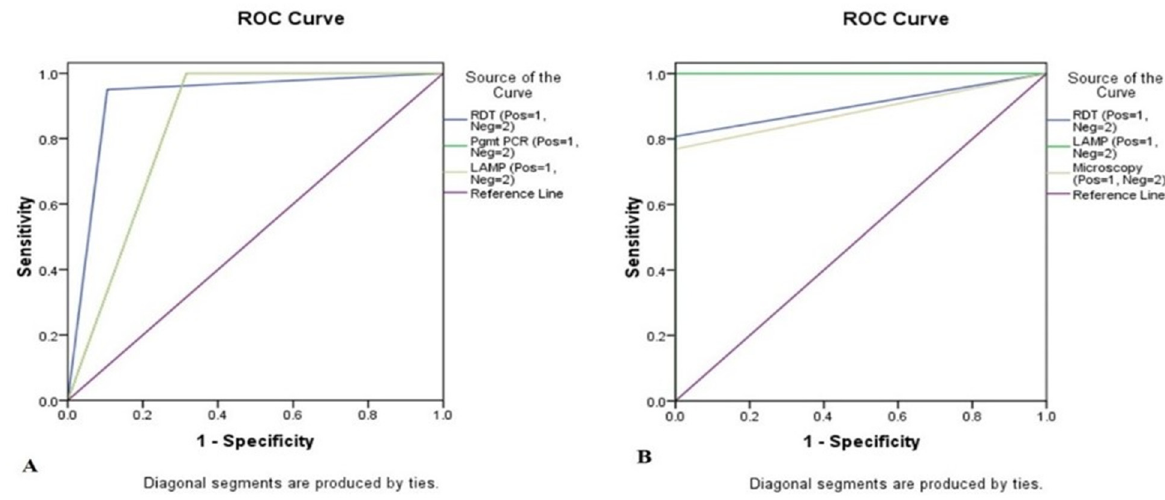
Figure 4. Receiver operating characteristic (ROC) curve analysis data showing prediction of case by the methods ( A ) when microscopy is the gold standard and ( B ) when PCR is the gold standard.